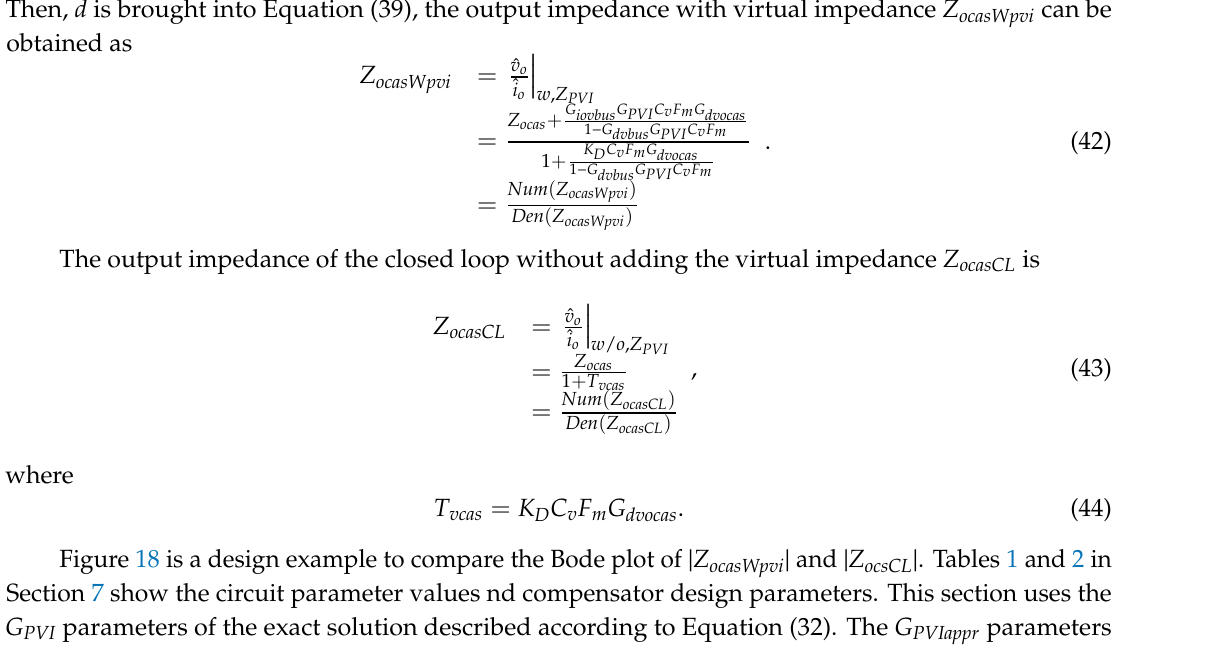
Figure 18. Bode plot of | Z ocasWpvi | and | Z ocsCL |.